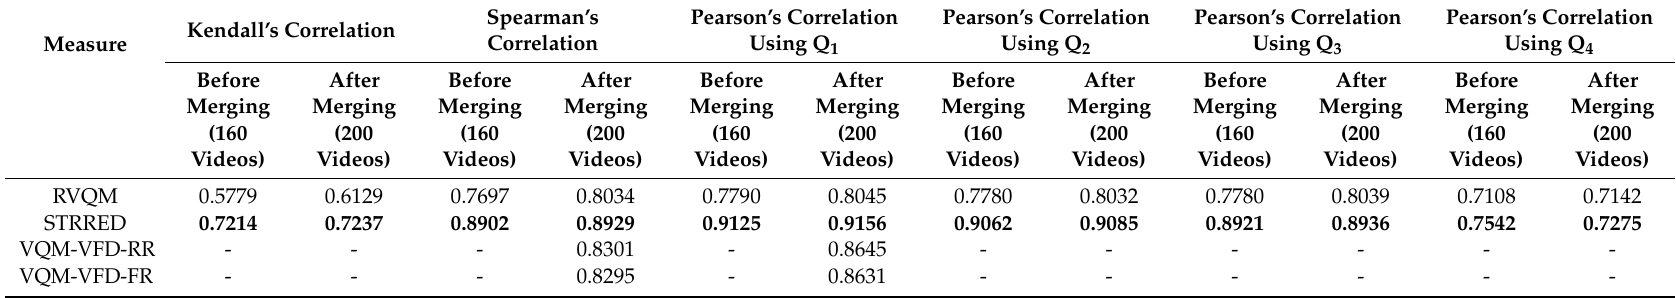
Table 10. Kendall’s, Spearman’s, and Pearson’s correlation, before and after combining RVQM and STRRED with freezing degradations; VQM-VFD-RR and VQM-VFD-FR correlation from [17]; mobile dataset (best values are marked in bold).